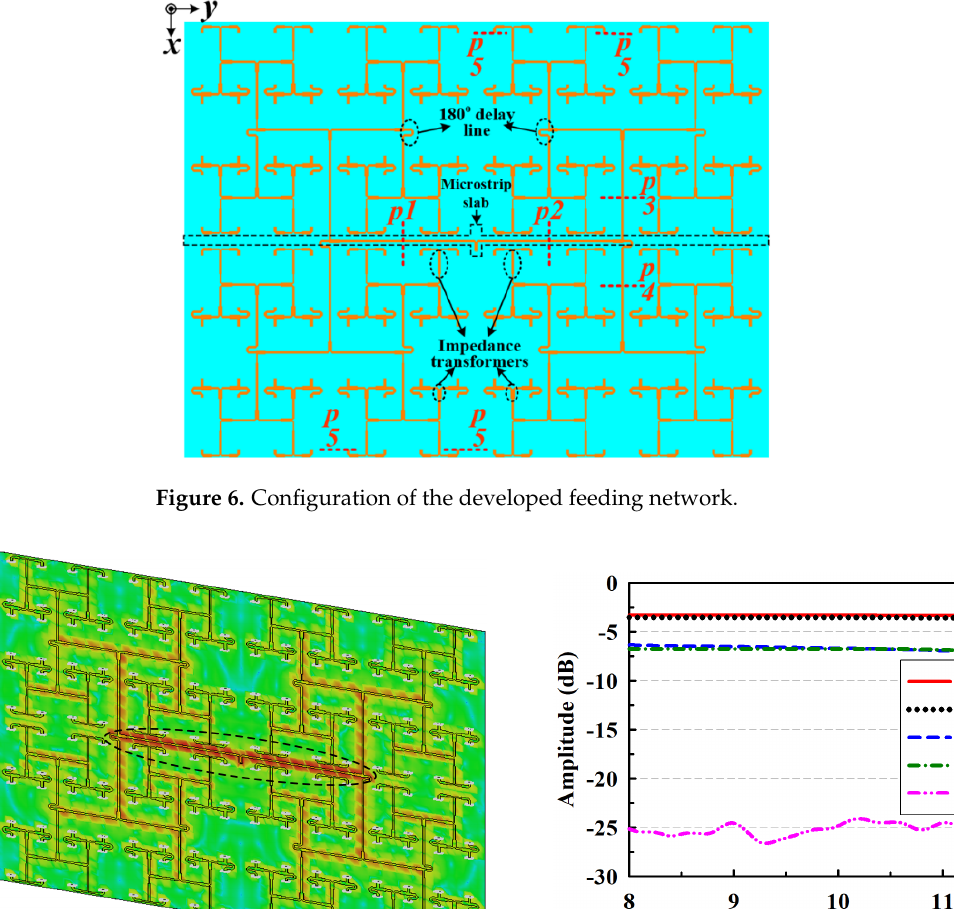
Figure 5. Simulated radiation patterns at 9.65 GHz for all of the subarrays of the proposed antenna: ( a ) XOZ-plane, and ( b ) YOZ-plane.